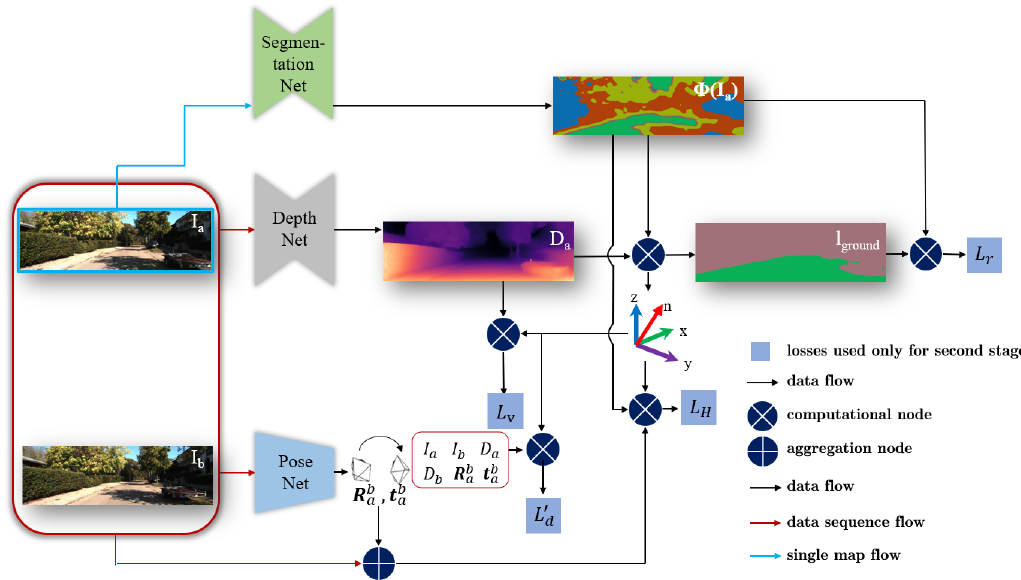
Figure 4. New losses L r , L H and L v are added in the second learning stage. In comparison with the first learning stage, the normal vector is fused to improve the calculation of loss L d , forming the new loss L (cid:48) . Details about this learning stage can be seen in the d